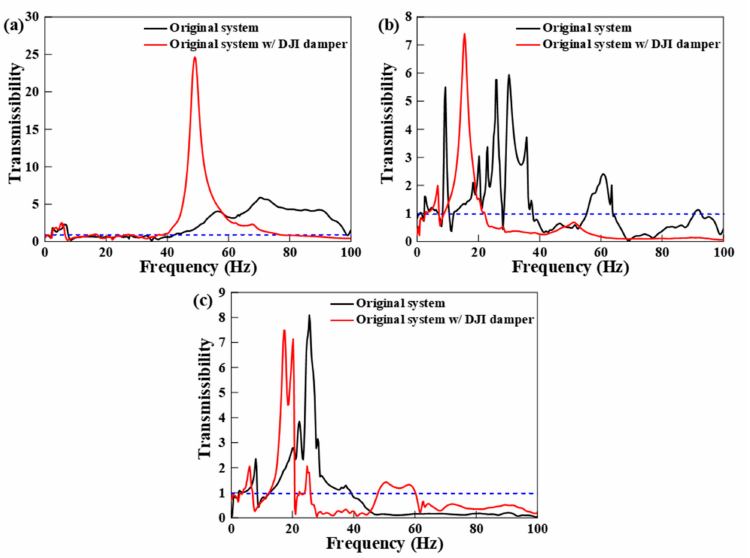
Figure 3. Measured transmissibility with modal testing: ( a ) fore-after direction, ( b ) side-by-side direction, and ( c ) vertical